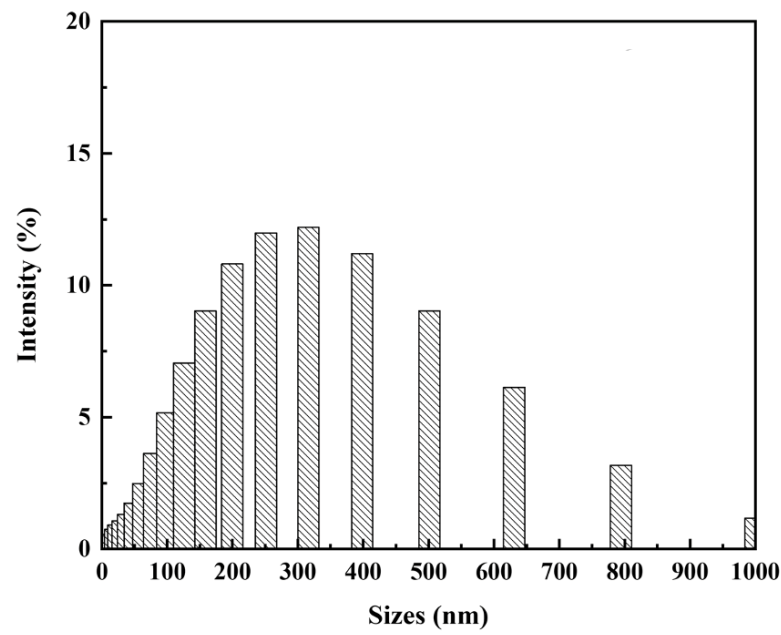
Figure 8. Dynamic Light Scattering Spectra of 15% PAN/DMF/CuNP Colloidal